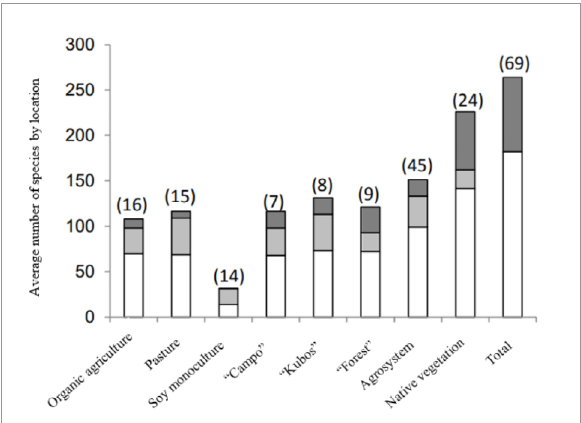
Figure 6: Occurrence of common, rare and unique species collected in the Rashad District between June 2019 and August 2020 with pitfall traps in different types of habitats. Numbers in parentheses indicate the number of sampled locations in each habitat. White bars indicate species considered typical, that is, that occurred more than once within the habitat; light grey bars indicate rare species that occurred only once in the habitat but that occurred in other habitats; and dark grey bars indicate species that occurred only once in the entire study. ‘Campo’ refers to rural formations, ‘Kubos’ refers to old-growth forests, and ‘Forest’ refers to forest formations.